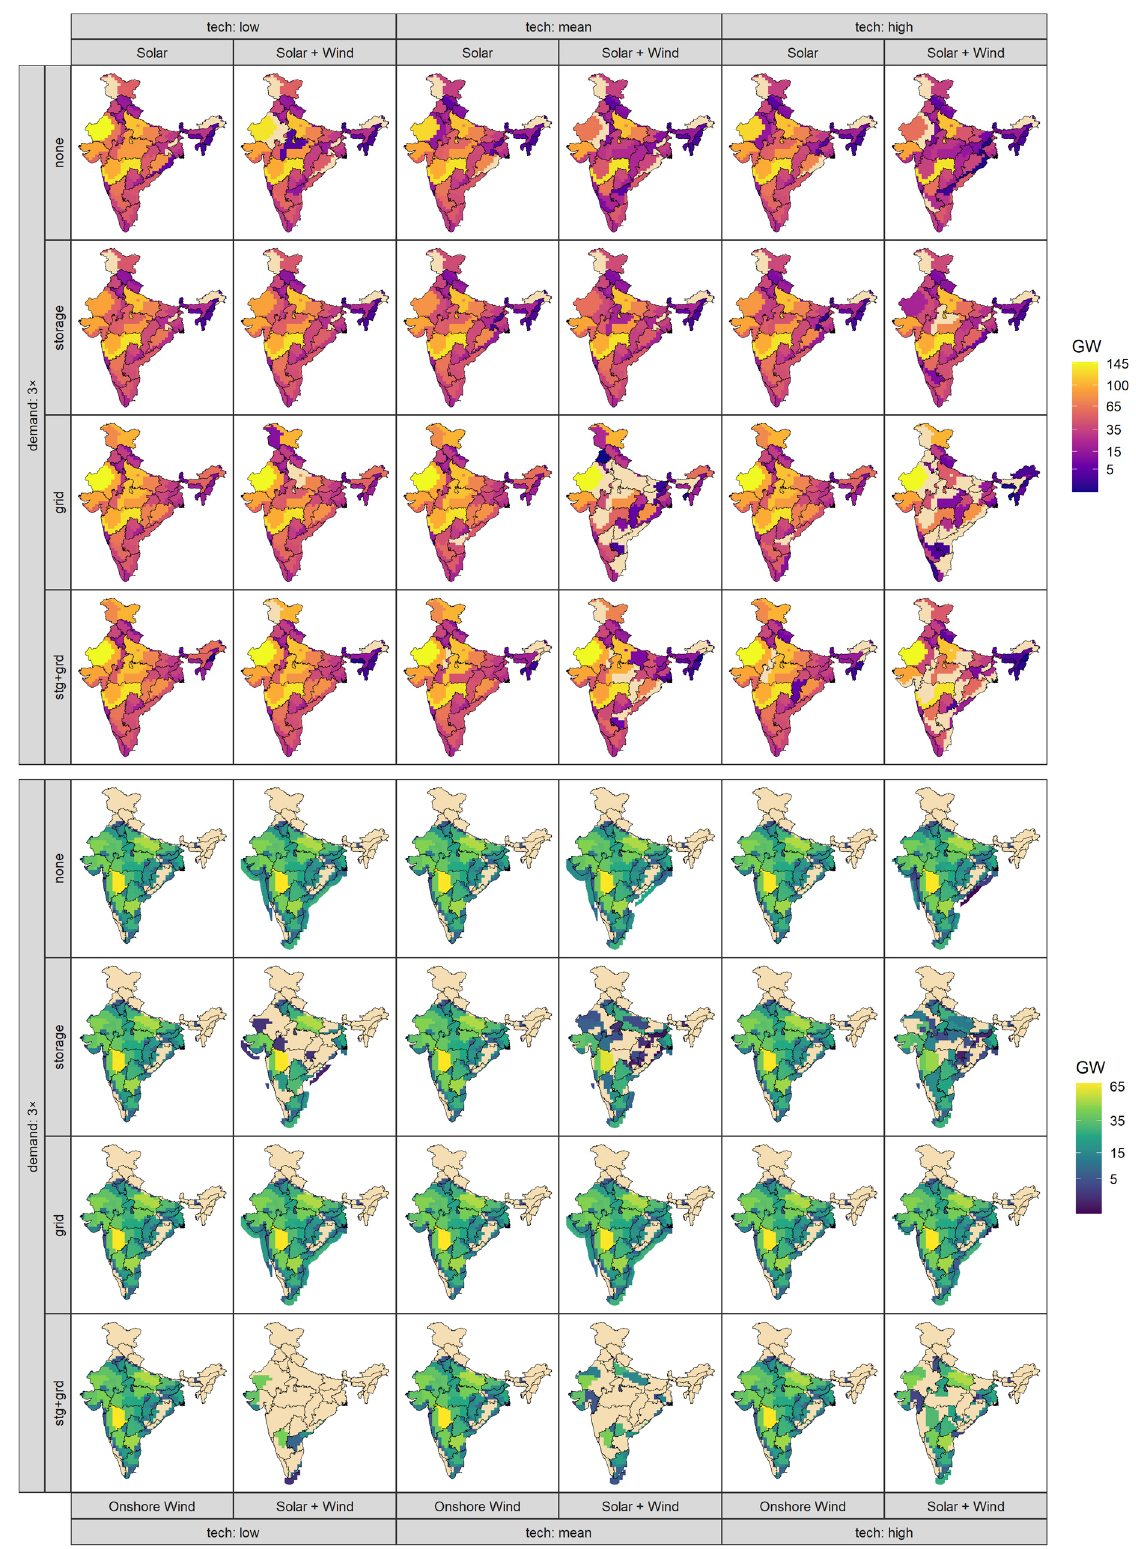
Figure A13. Optimised solar and wind generation capacity by scenario and cluster, demand level triple that of 2019.